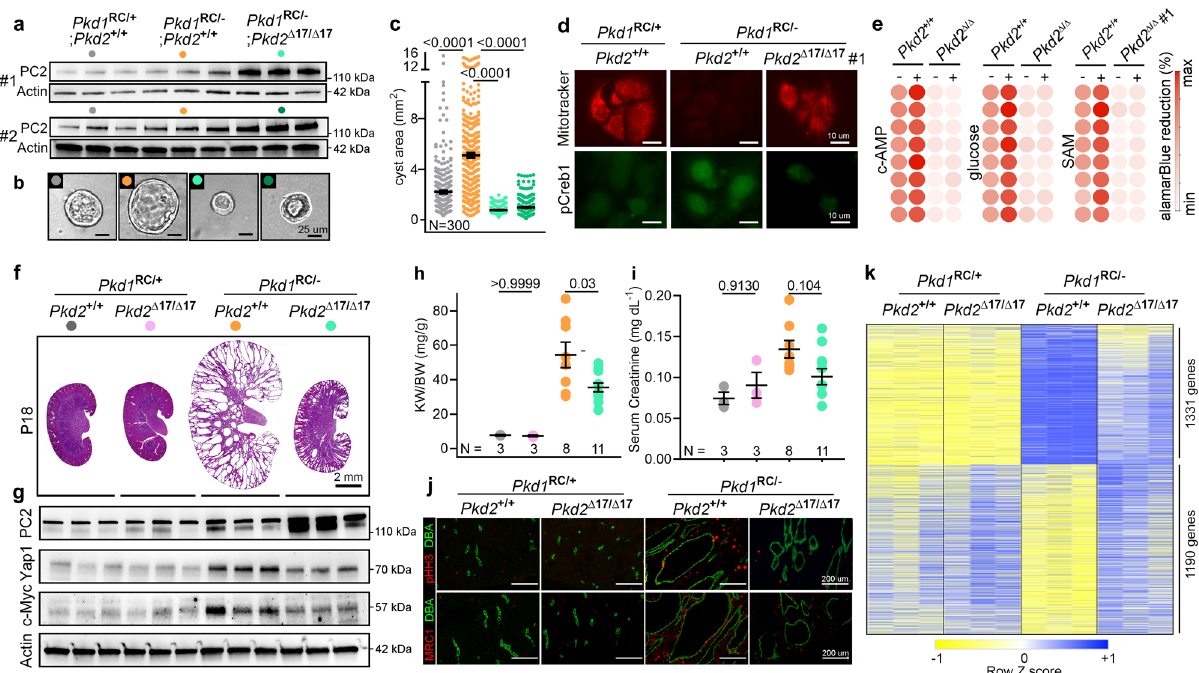
Fig. 4 | Pkd2 derepression retards cyst growth in Pkd1 -mutant models. a Immunoblot showing Polycystin-2 (PC2) expression in cells with the indicated genotypes. miR-17 motif deletion from Pkd2 3 ′ -UTR leads to higher PC2 expression in Pkd1 RC/- cells. Actin serves as the loading control. #1 and #2 refer to the